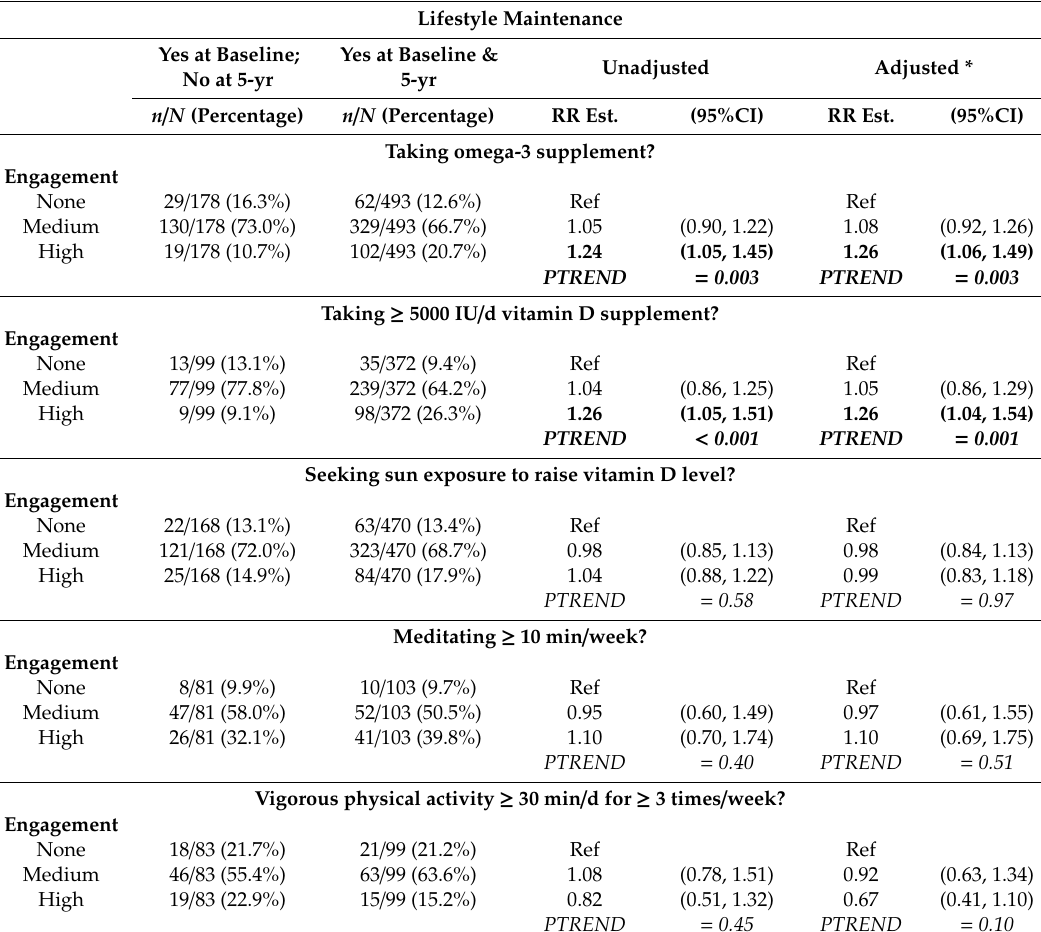
Associations of maintaining lifestyle behaviours at five years with baseline health communication